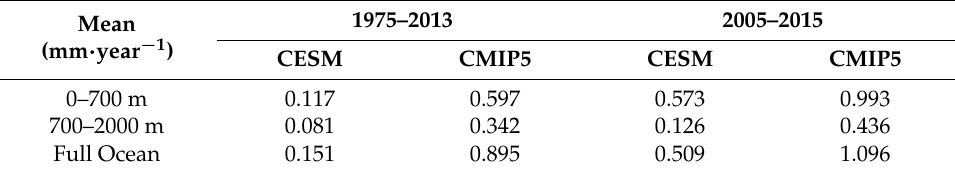
Table 3. 95% range in ensemble steric sea-level rise trends for both periods and ensembles over all evaluated